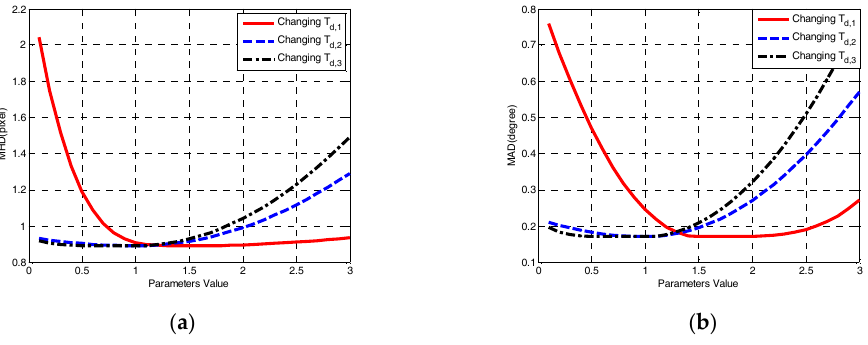
Figure 9. Parameter sensitivity analysis: ( a ) Mean height deviation (MHD) with changing control parameters. ( b ) Mean angle deviation (MAD) with changing control parameters.